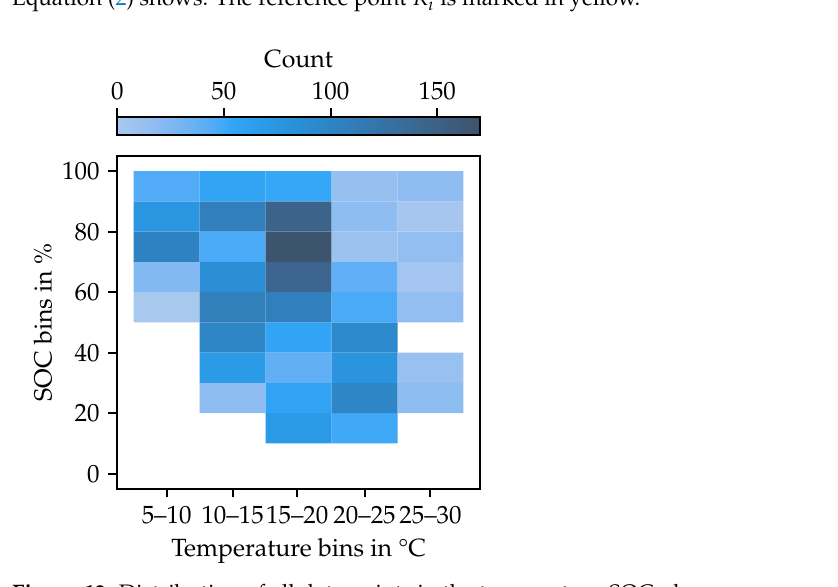
Figure 13. Distribution of all data points in the temperature-SOC